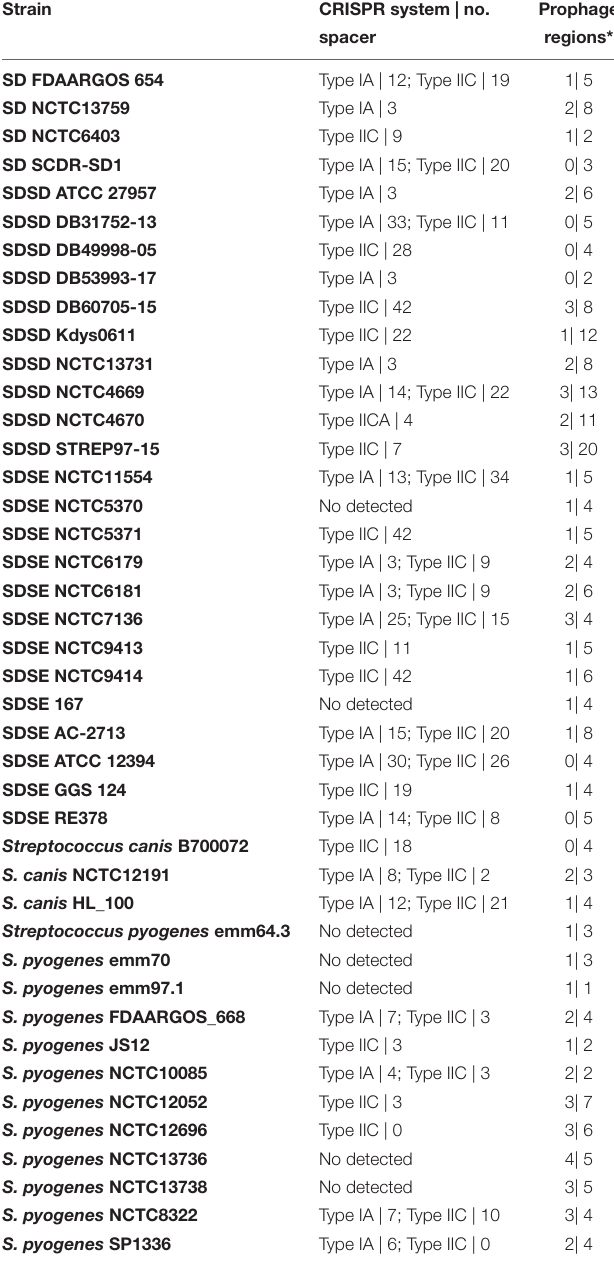
TABLE 3 | Identification of CRISPR/Cas systems and prophage or prophage-like regions. Strain CRISPR system |